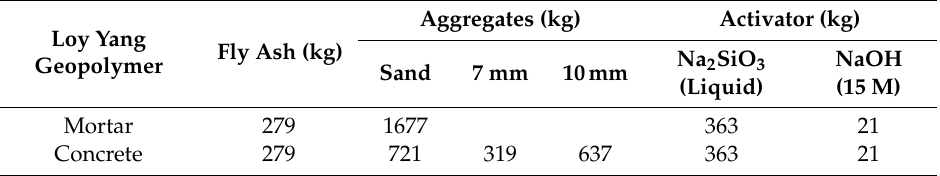
Table 3. The optimum mix design (kg / m 3